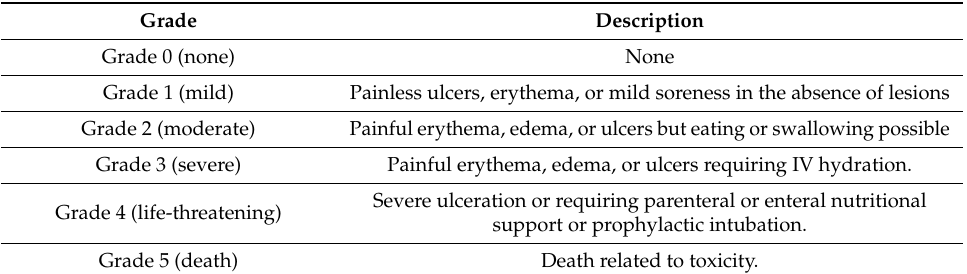
Table 1. National Cancer Institute assessment scale for oral mucositis.